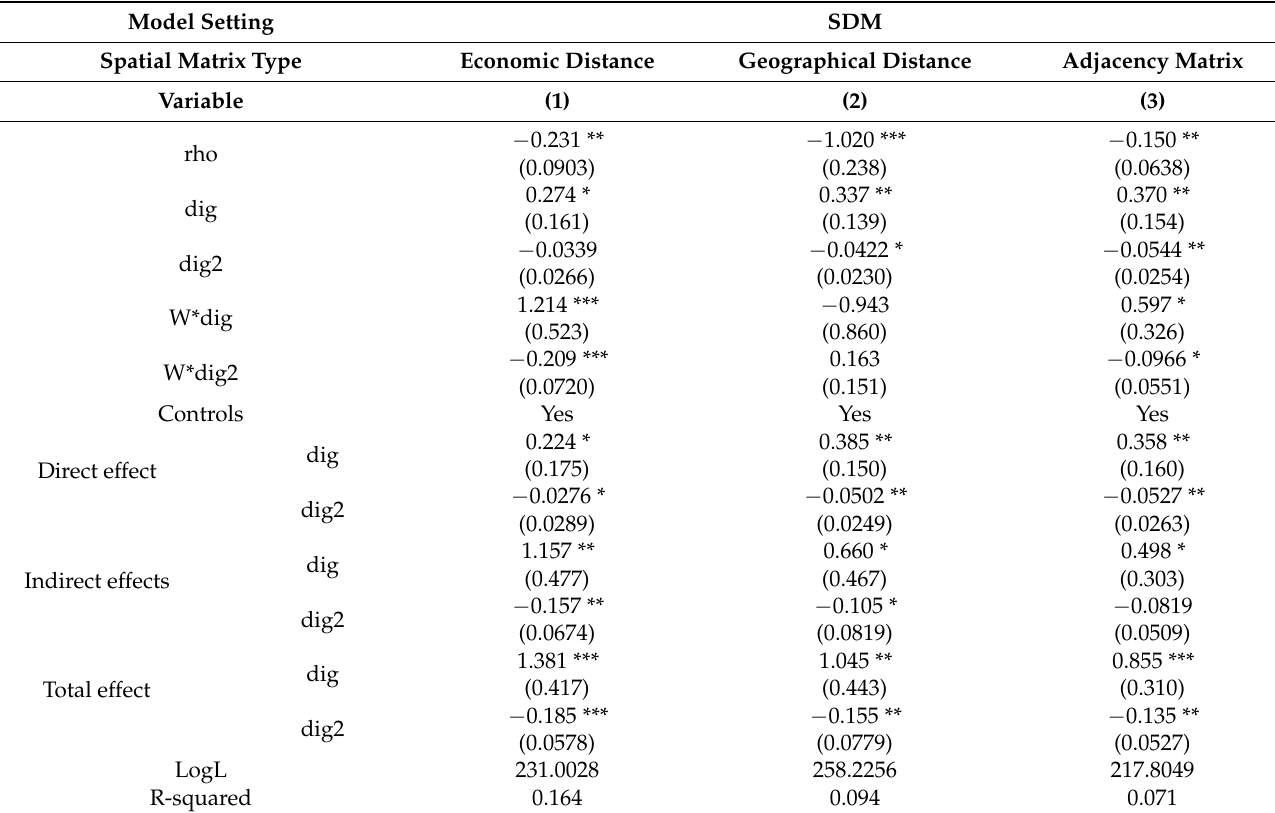
Table 8. Regression results of the spatial model of digital innovation level affecting carbon emissions in the transportation